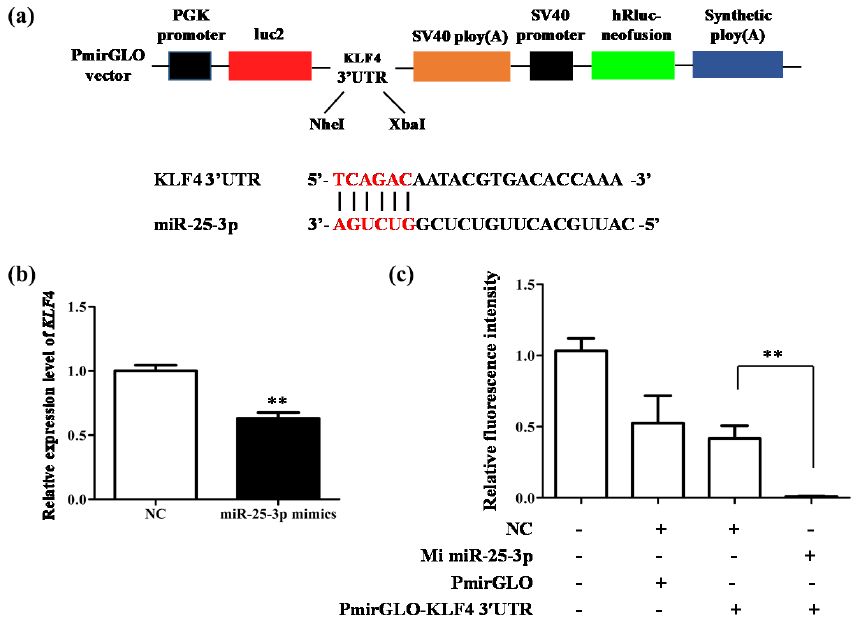
Figure 5. miR-25-3p can target 3 (cid:48) -UTR of KLF4 . (a) Schematic diagram of pmirGLO dual luciferase and the interaction between miR- 25-3p and KLF4 . (b) The mRNA expression level of KLF4 after miR-25-3p overexpression. (c) KLF4 3 (cid:48) -UTR dual luciferase vector was co-transfected with miR-25-3p mimics and negative